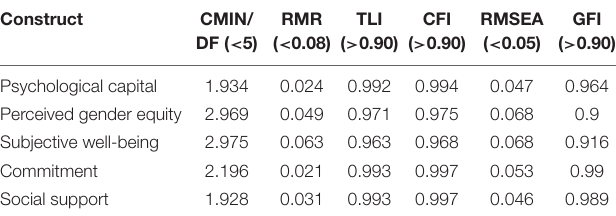
TABLE 3A | Measurement model fit indices of study